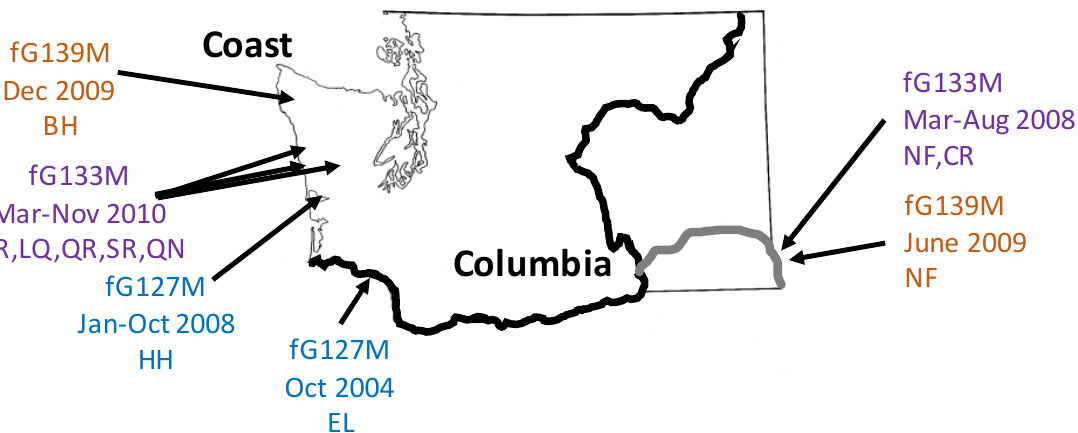
Figure 3. Locations and dates of detection for viruses with matching fullG genotypes identified in three transmission links of MD IHNV from Columbia region sources to coastal region steelhead sink